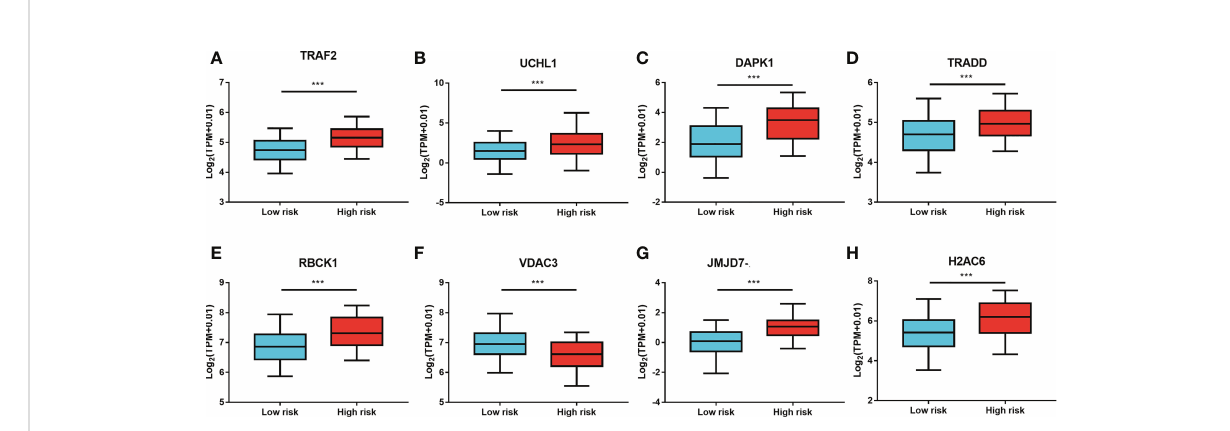
FIGURE 4 The expression levels of LASSO genes between the low-risk group and the high-risk group. The expression of the eight necroptosis-related genes [ TRAF2 (A) , UCHL1 (B) , DAPK1 (C) , TRADD (D) , RBCK1 (E) , VDAC3 (F) , JMJD7-PLA2G4B (G) , H2AC6 (H) ] between the low-risk group and the high-risk group in the TCGA cohort. ** P < 0.01, *** P <